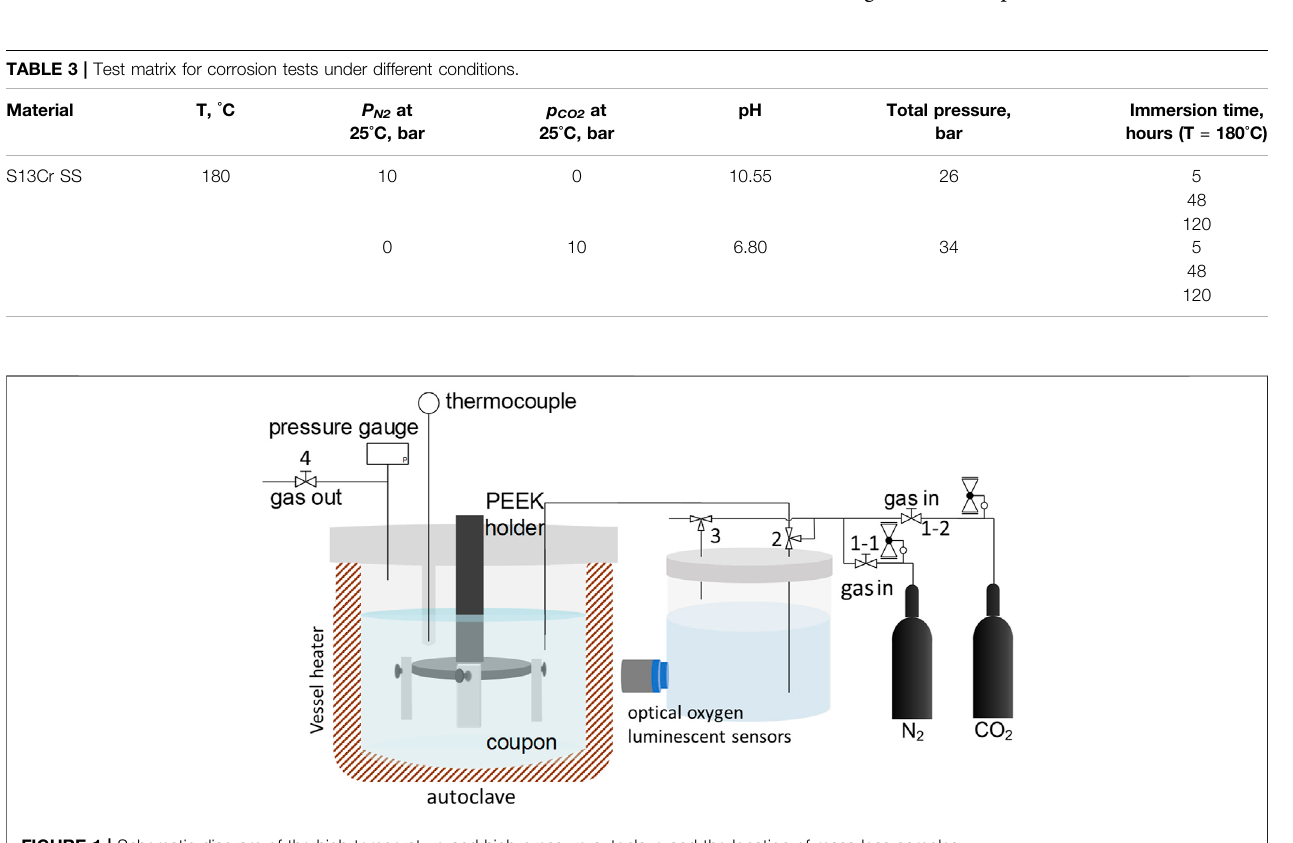
Frontiers in Materials |